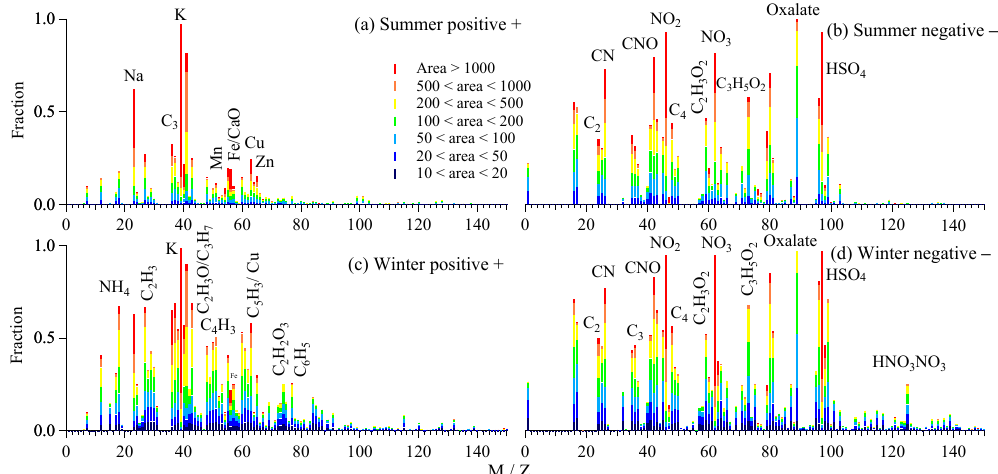
Figure 2. The averaged positive and negative ion mass spectra of oxalic-acid-containing particles is investigated in summer and winter: (a) summer positive, (b) summer negative, (c) winter positive and (d) winter negative. The color bars represent each peak area corresponding to a specific fraction in individual